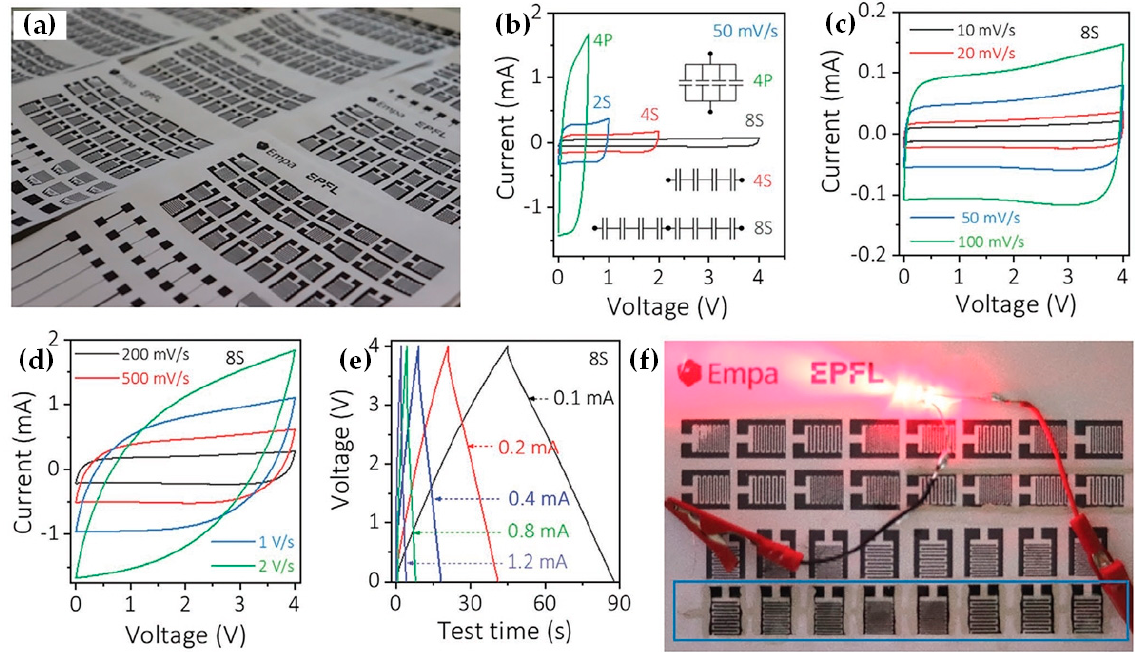
Figure 9. Scalable production of micro-supercapacitors based on MXene sediment inks. ( a ) Optical image of a screen-printed MXene-based microsupercapacitor, showing the great promise of scale-up production of high-performance MSCs. ( b ) CV profiles of different tandem devices at 50 mV s-1. ( c , d ) CVs of a tandem device with eight MSCs connected in series at different scan rates show a high-rate response. ( e ) GCD profiles of a tandem device with eight MSCs connected in series, indicating symmetric, linear curves at various currents. ( f ) Optical image of the tandem device to power an LED light, demonstrating the feasibility of the as-printed tandem device for practical applications, reprinted with permission from [95] .